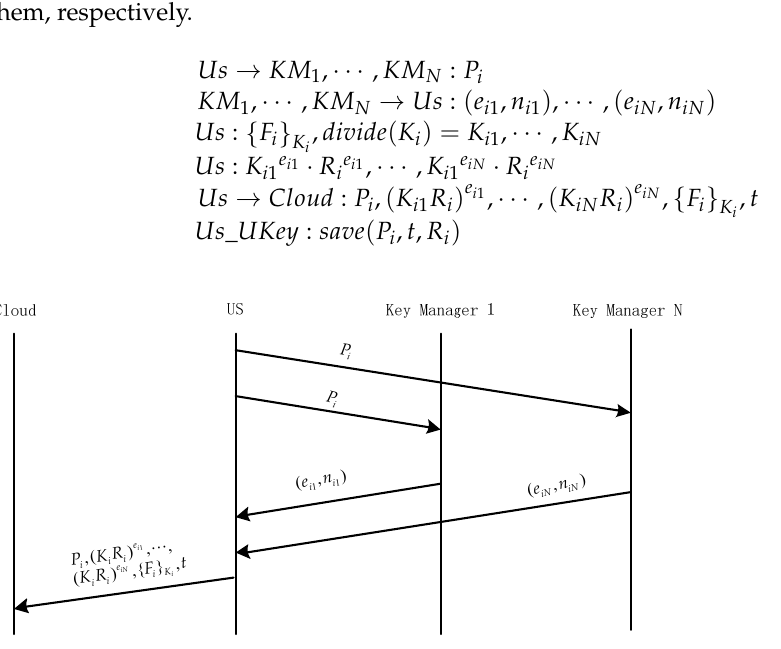
Figure 6. ADSS single KM file upload.